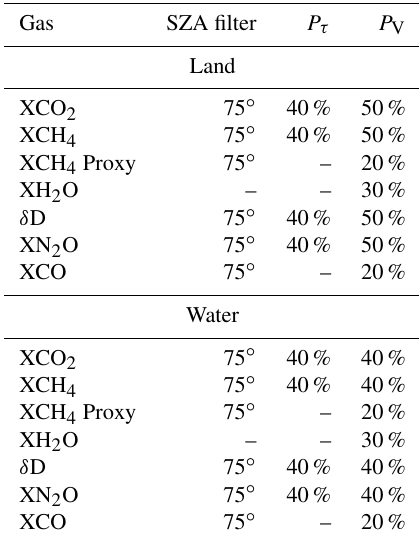
Table 4. Filter settings for all products; “–” denotes that no limit is applied.